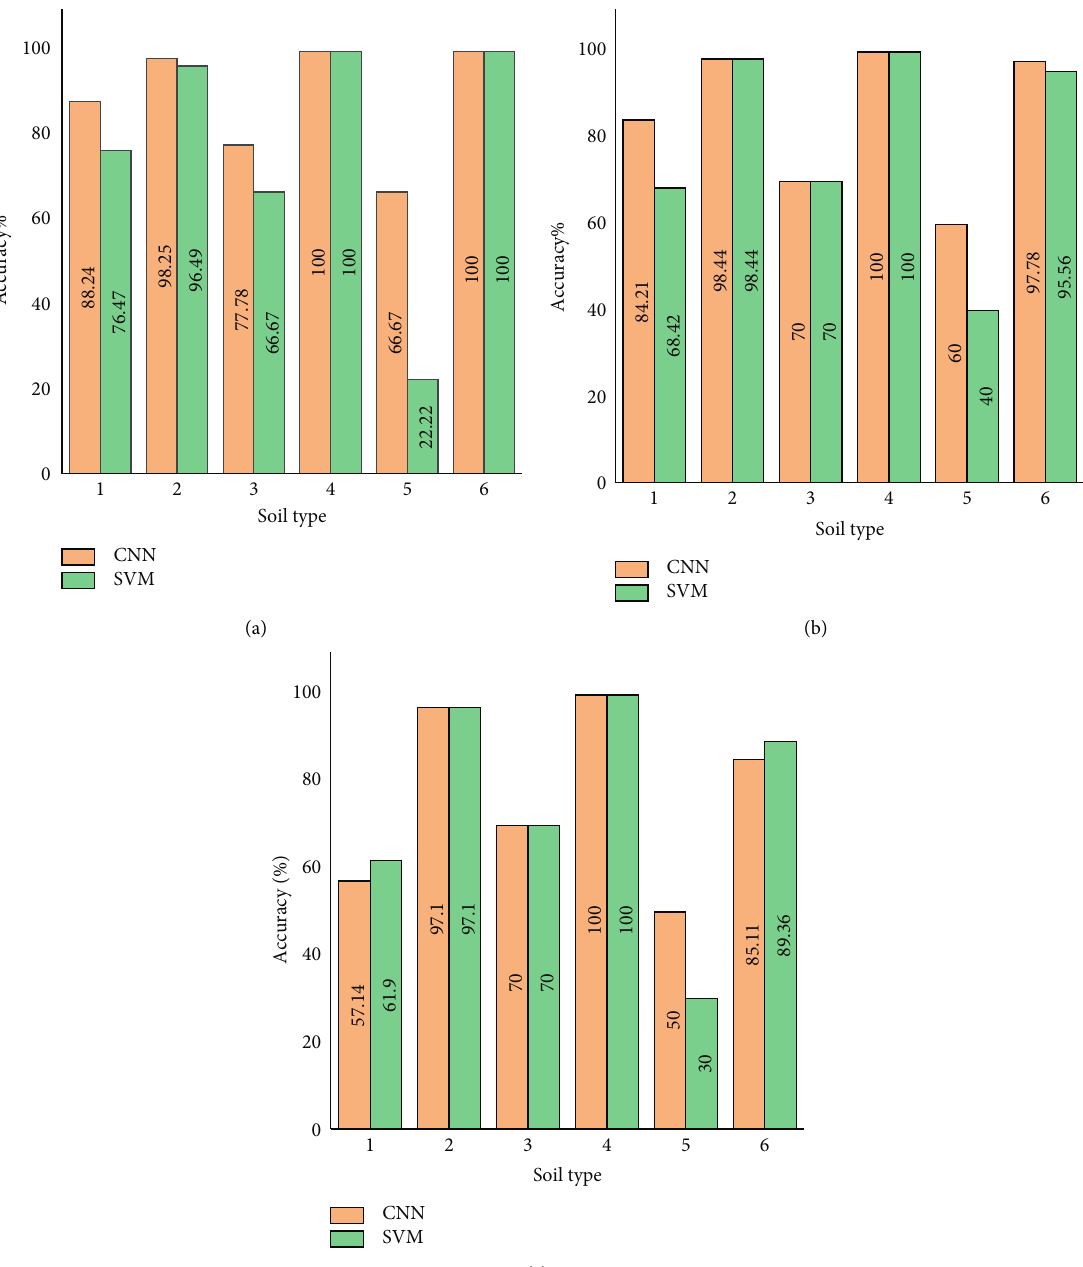
Figure 4: The classification results of six types of soil in the test set based on support vector machine and convolutional neural network by random method (1 orchard, 2 woodlands, 3 tea plantations, 4 farmlands, 5 bare lands, and 6 grasslands): (a) 1/3 proportion, (b) 1/4 proportion, and (c) 1/5